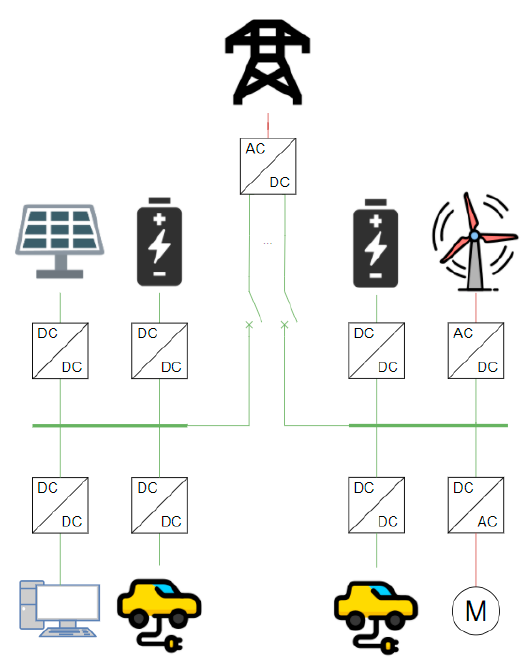
Figure 5. Radial parallel configuration.